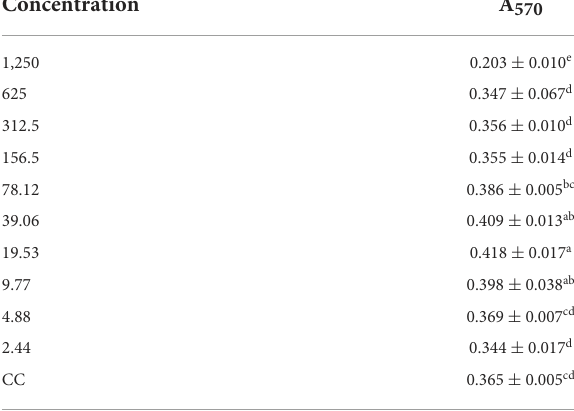
TABLE 1 A570 value of every polysaccharide groups 1,250–2.44 µ g mL − 1 ( n =